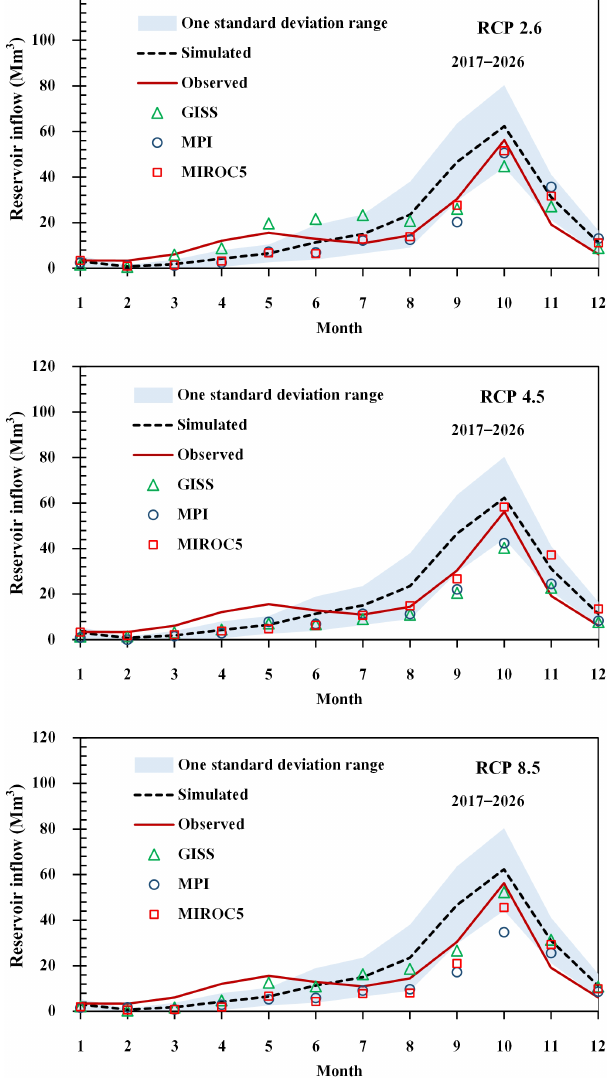
Figure 10. Projected mean monthly reservoir inflows under 3 sce- narios for the years 2017–2026 at Nong Pla Lai